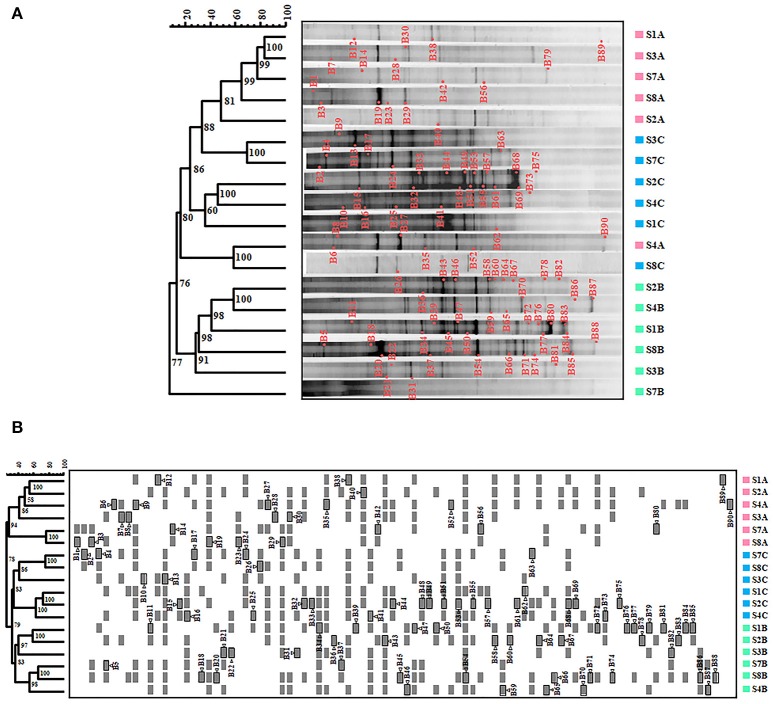
Bacteria in Rambla Salada analyzed by DGGE. (A) Pearson coefficient-based analysis. (B) Dice coefficient-based analysis. The scale bar indicates the percentage of similarity. Numbers in nodes represent the cophenetic correlation coefficient values. Triangles followed by gray shaded squares bands re-amplified and sequenced to conduct the phylogenetic study. S1A to S8A, sampling sites in June 2006; S1B to S8B, sampling sites in February 2007, and S1C to S8C, sampling site in November 2007.